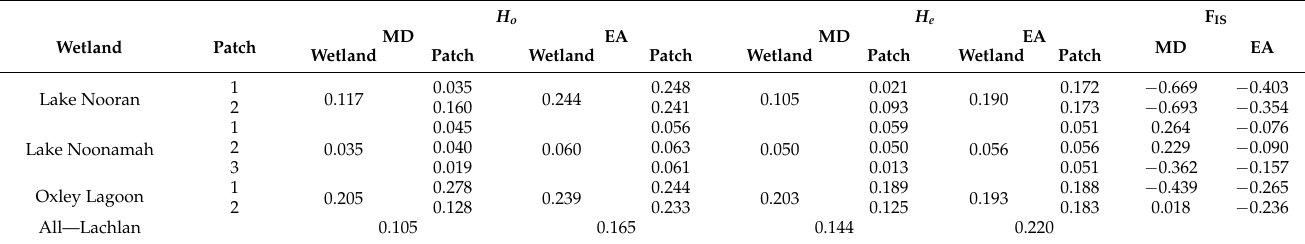
Table 3. Observed ( H o ) and expected ( H e ) genetic diversity within wetlands, patches, and overall for Marsilea drummondii (MD) and Eleocharis acuta (EA). F IS = (median) inbreeding coefficient. H o H e F IS